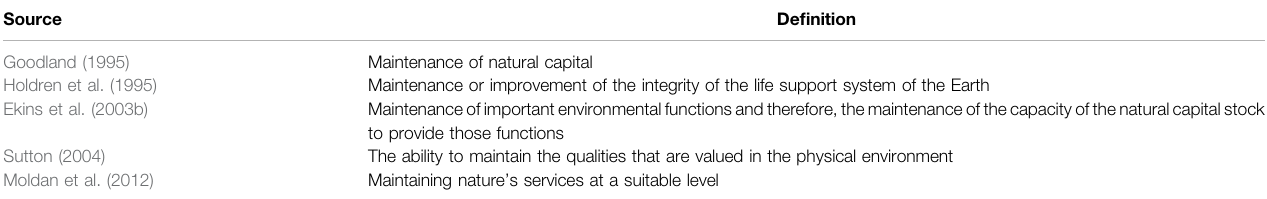
TABLE 1 | De fi nitions of environmental sustainability. Source De fi nition Goodland (1995) Maintenance of natural capital Holdren et al.